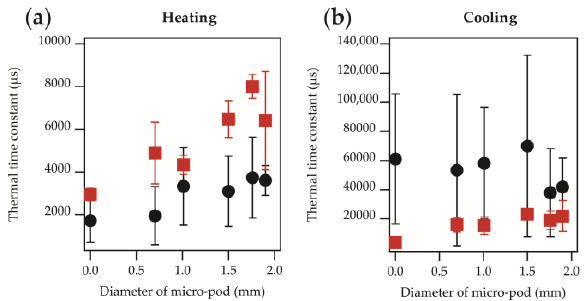
Figure 4. Thermal time constants as a function of the micro-pod diameter. Data presented shows experiments where an oil bath was used ( ) or the samples were attached directly to a hotplate ( ). ( a ) Heating time constant; ( b ) Cooling time constant. In both cases the effect of the micro-pod on the time constants were negligible within the experimental error.